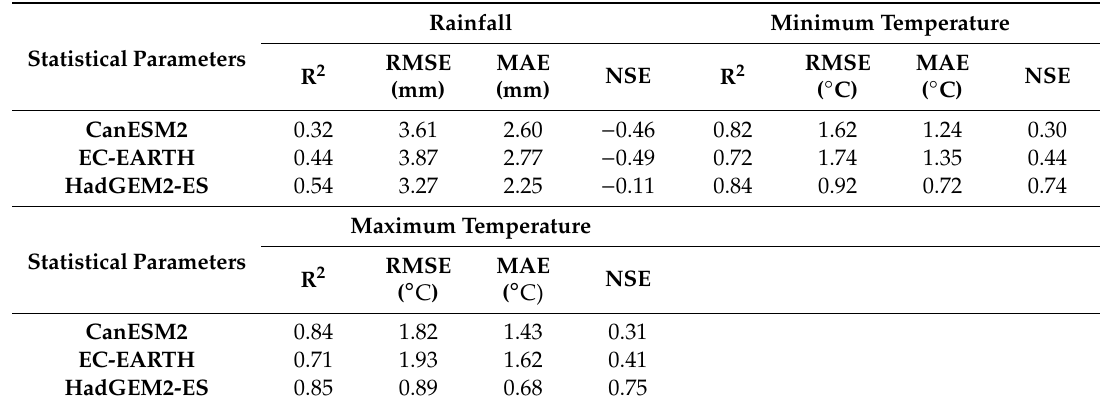
Table 2. Statistical evaluation of climate models on historical data